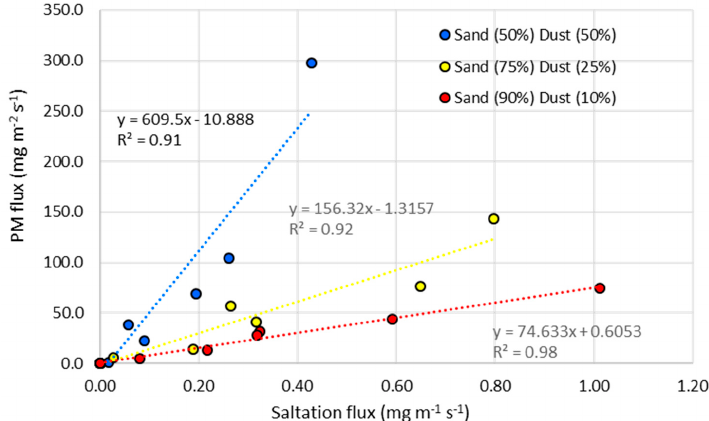
Figure 5. Correlation between saltation flux and PM10 (PM that is less than 10 micrometers in diameter) flux calculated for each soil sample under all the shear velocities applied in the wind tunnel.